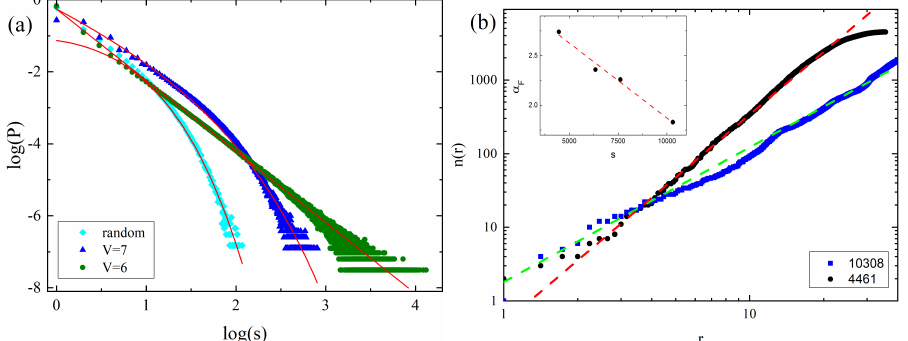
Figure 9. ( a ) Double logarithmic plot of probability distribution p V ( s ) of sizes s of V -clusters. random : Reference system of randomly distributed cells. Solid line: fits, Equation (41). ( b ) Double logarithmic plot of number of cells n ( r ) in a 6-cluster as a function of the distance r , see text for more details. Red and green dashed lines: power-law fits with α F = 2.74 and 1.83, respectively. Inset: plot of fractal dimension α F as a function of cluster size s . T = 0.25. Based on